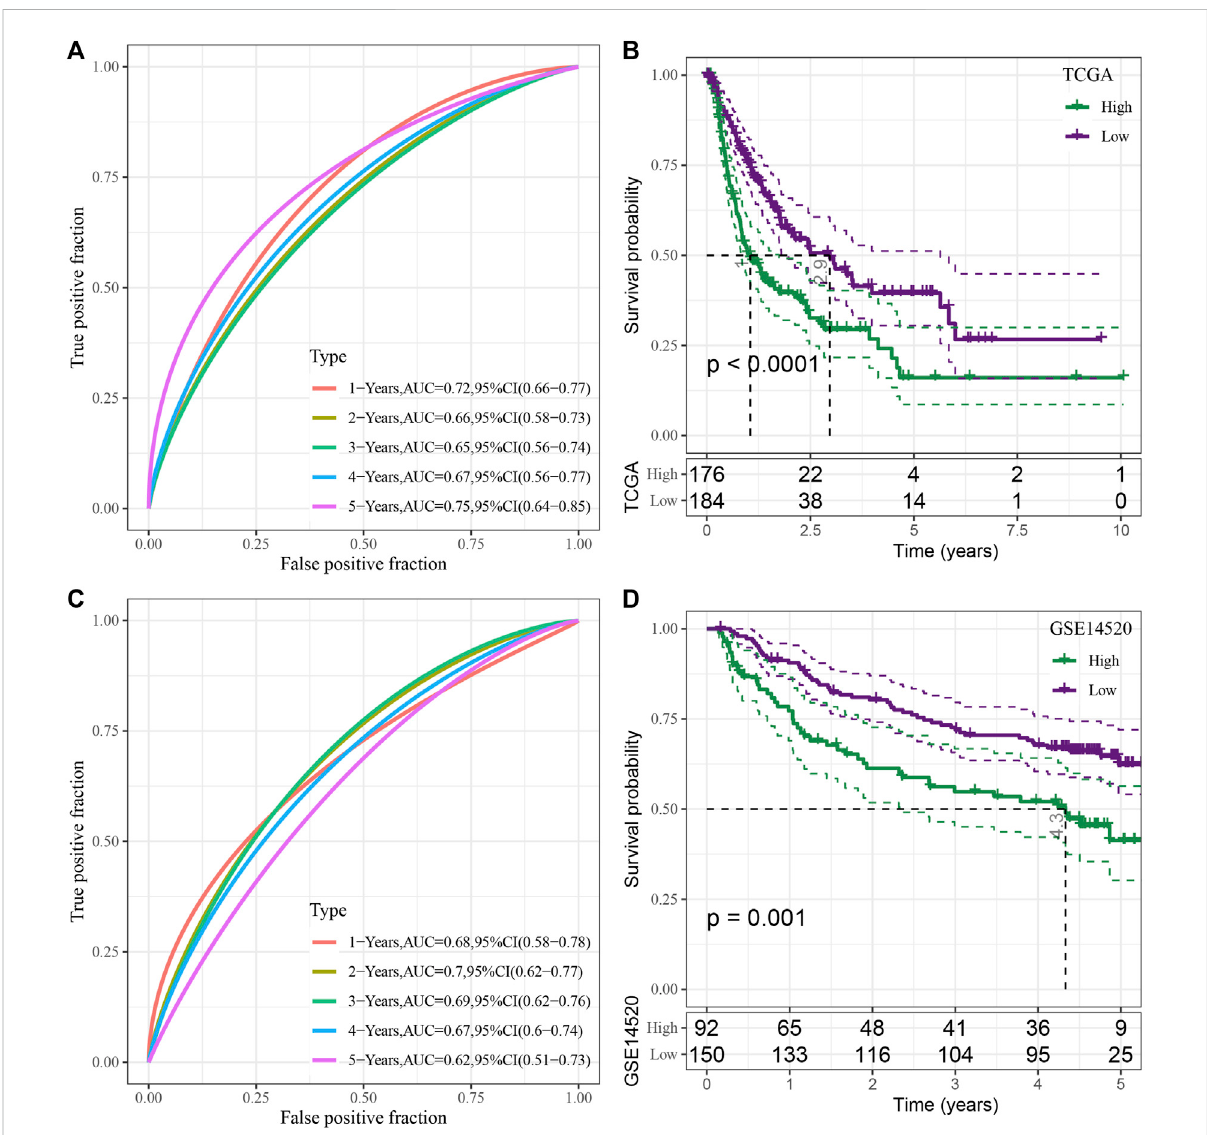
FIGURE 6 ConstructionandassessmentoftheRSmodelbasedonthesevencuproptosis-linkedgenes. (A) ROCcurveofriskmodelconstructedbyseven genes in the TCGA-LIHC dataset; (B) KM curve of risk model constructed by seven genes in the TCGA-LIHC dataset; (C) ROC curve of risk model constructed by seven genes in the GSE14520 dataset; (D) KM curve of the risk model constructed by seven genes in the GSE14520